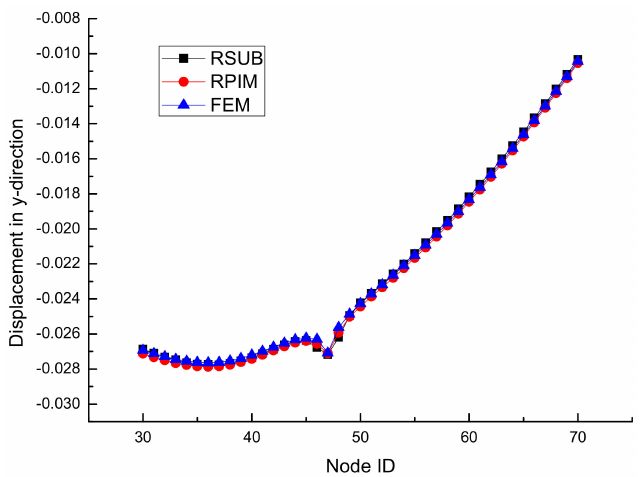
Figure 18. Displacement in the y-direction along the upper side of the boundary.